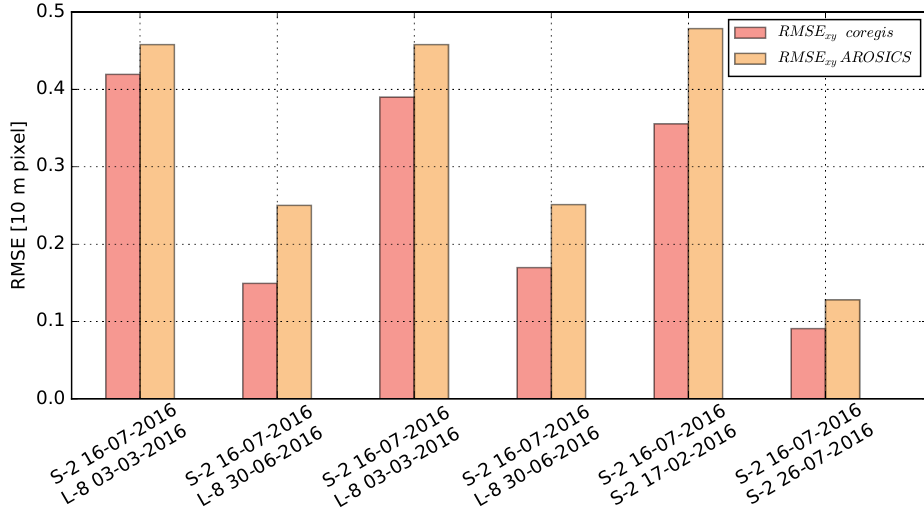
Figure 5. Comparison of the co-registration RMSEs obtained after geometrical corrections with AROSICS and coregis for one of the Ukrainian test site (34UFU). (note, L-8: Landsat-8; S-2: